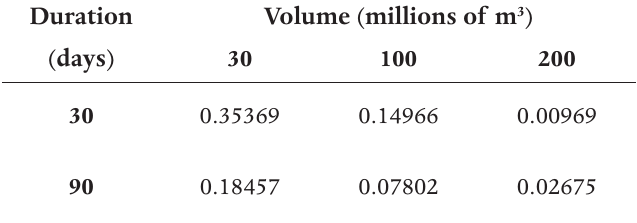
Table 1. Events classification for the durations/volumes considered for the simulations carried out, as The probabilities of occurrence for each